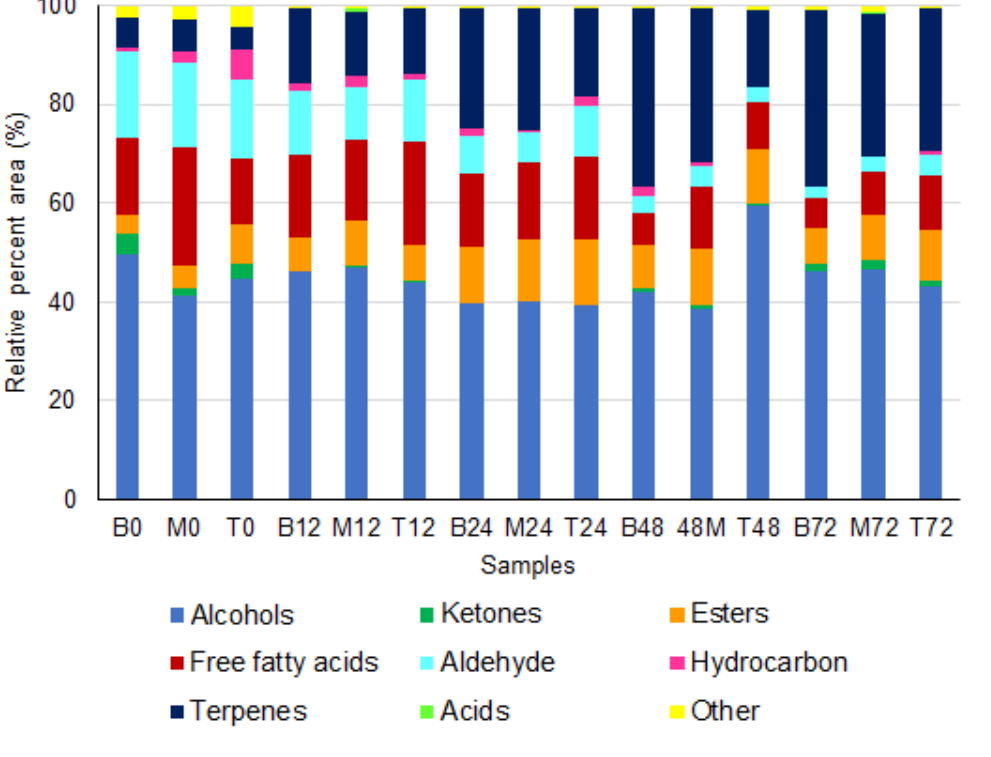
Figure 5. Chemical groups identified in the bottom (B), middle (M), and top (T) layers in the fermentation liquid fraction. The number after each letter represents the fermentation time (e.g., B0 = bottom layer at 0 h).